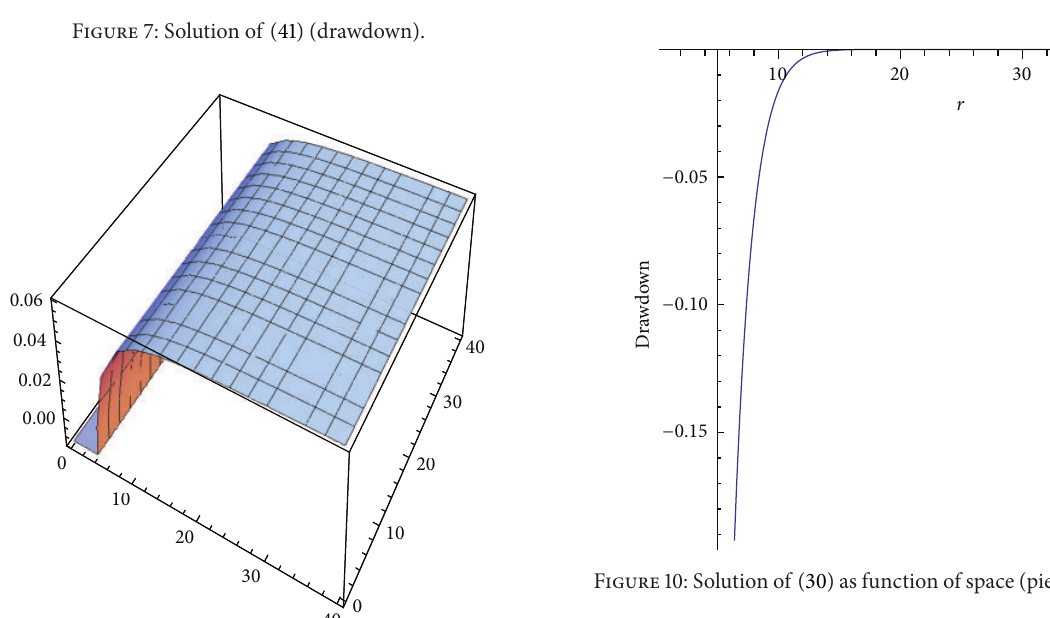
Figure 9: Barker’s solution.